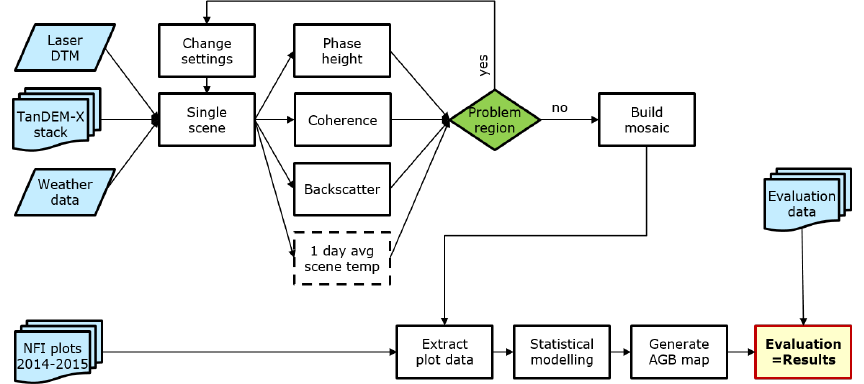
Figure 1. Flowchart of the working process, with material, data processing, modelling and evaluation. NFI, National Forest Inventory.